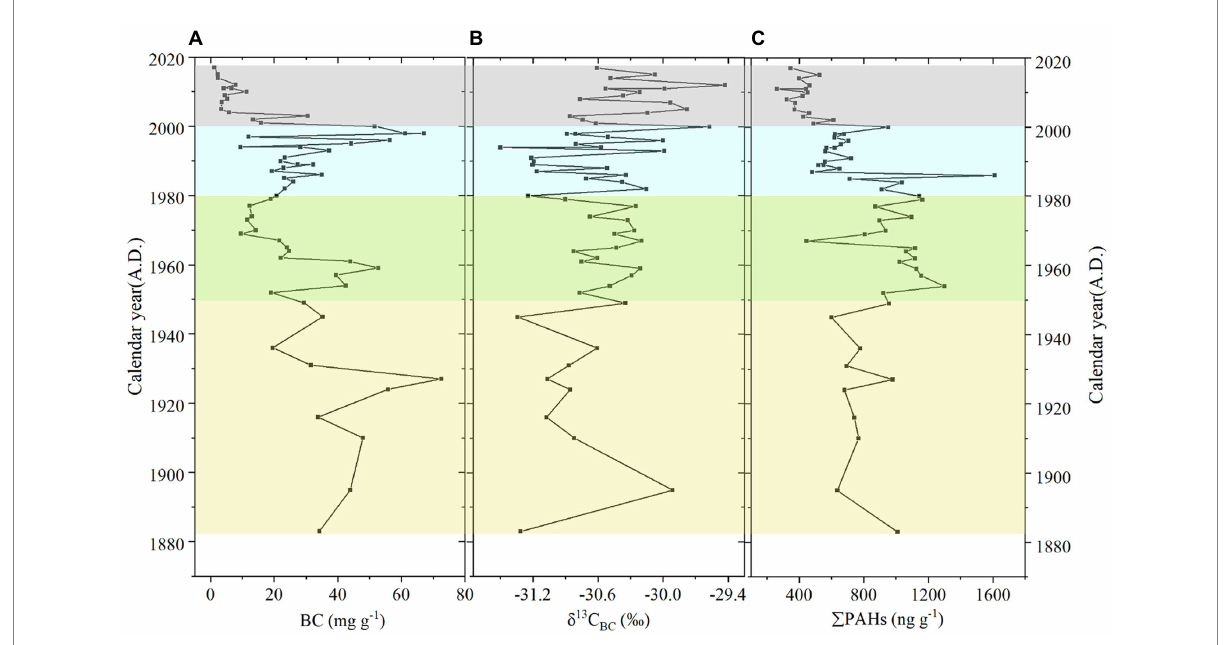
FIGURE 4 The contents of BC (A) , δ 13 C BC (B) , ratios, and the total PAHs content (C) , in the core of